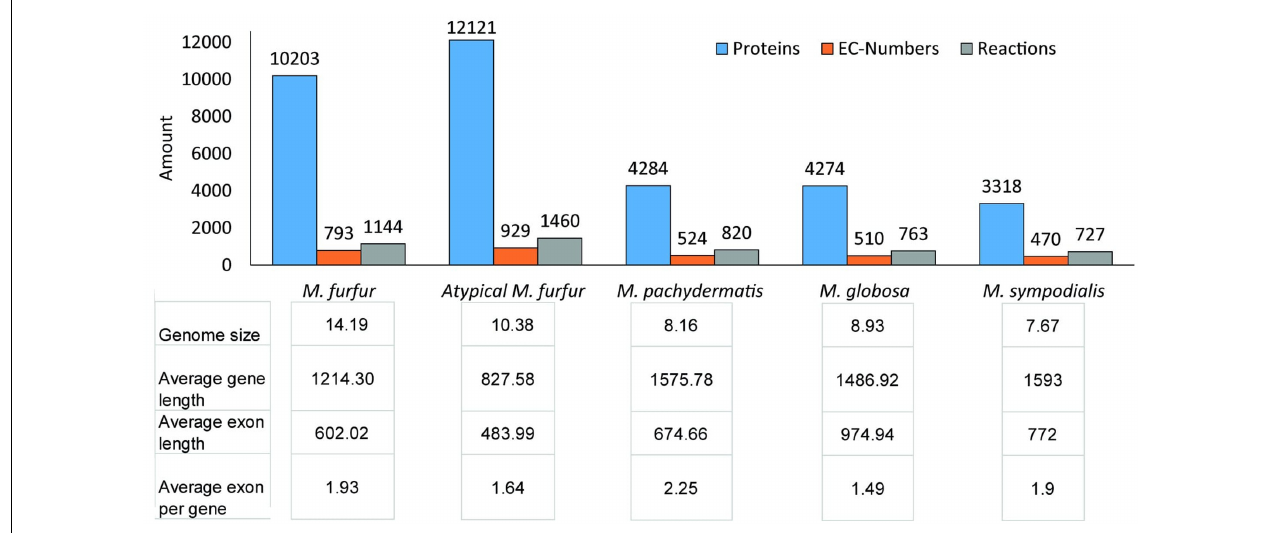
FIGURE 2 | Annotation data for each species: for the M. furfur strains, the predicted proteins were obtained from MAKER (Cantarel et al., 2007). For all the strains, the ECs were obtained from KAAS (KEGG Automatic Annotation Server) (Moriya et al., 2007) and Blast2GO (Conesa and Götz, 2008), the reactions were retrieved from the KEGG database, and the annotation statistics were calculated with genome tools (Gremme et al., 2013).